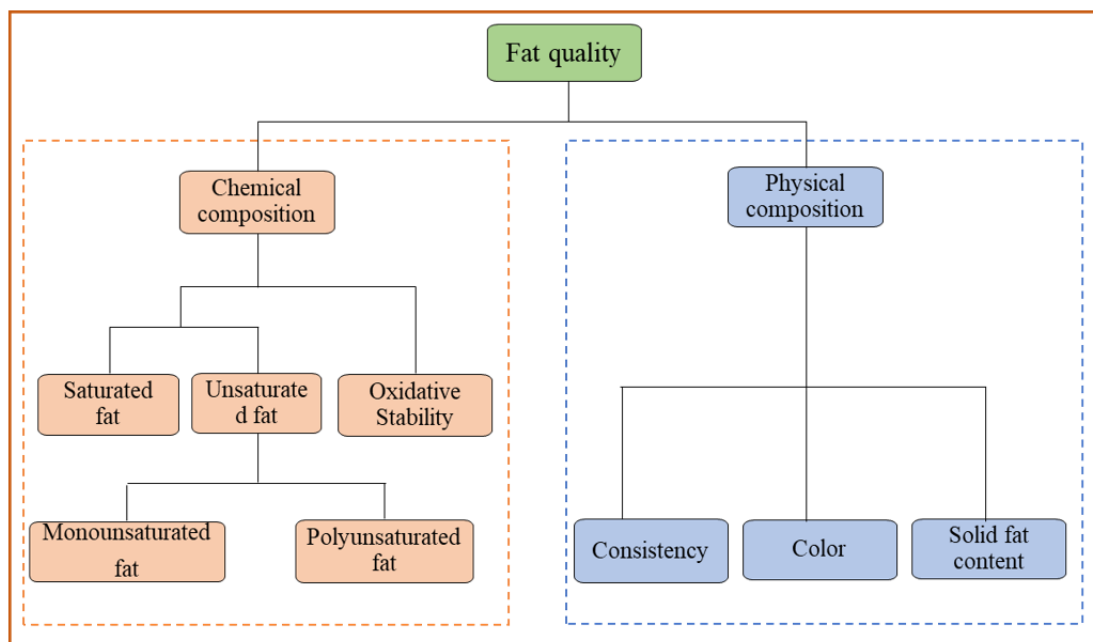
Figure 1. Chemical and physical parameters used to desceibe the quality of fat.